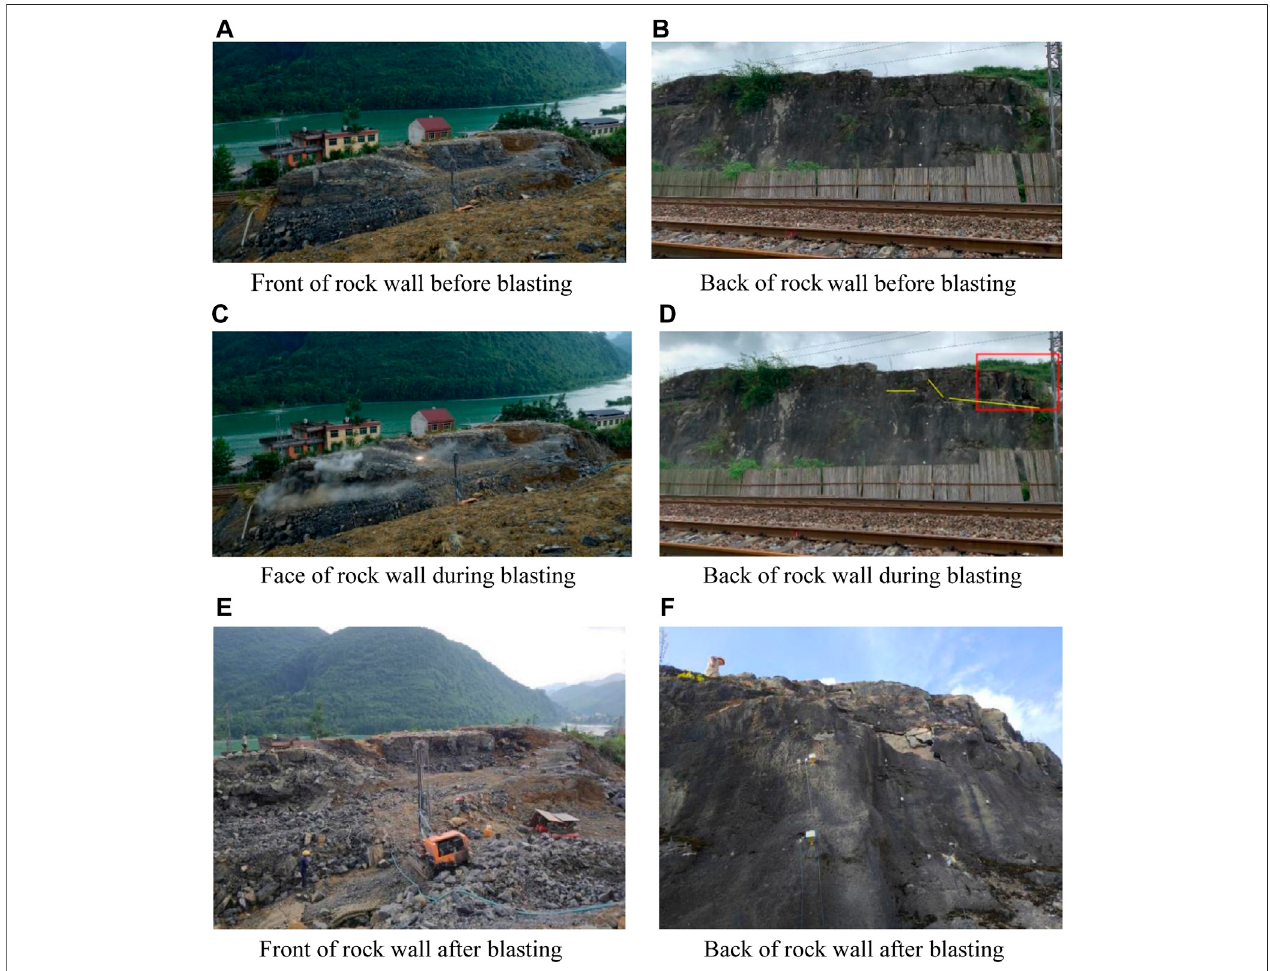
FIGURE 13 | Site map of the third rock wall